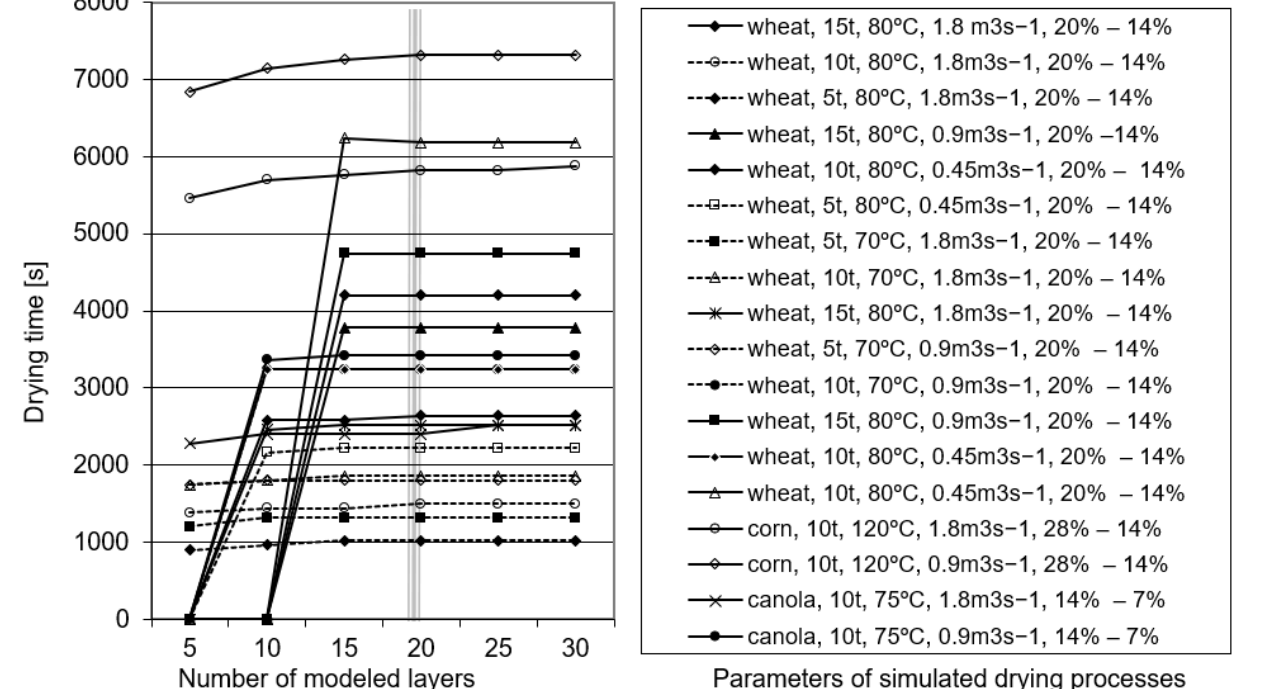
Figure 6. The influence of the number of layers on the drying time of wheat, canola, and corn grain.